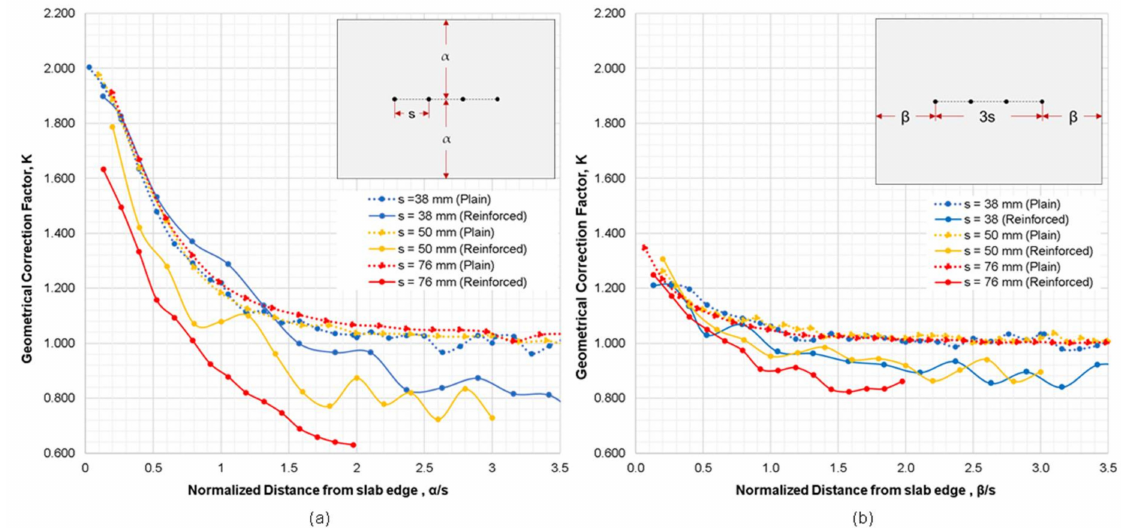
Figure 8. Variation of geometrical correction factor, K , obtained from the numerical simulation cases 2 and 3 for the reinforced concrete models with respect to the normalized distance from slab edge where ( a ) probes are parallel to edge of slab, and ( b ) probes are perpendicular to the slab